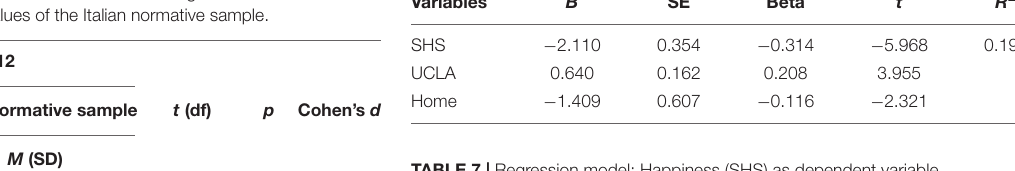
TABLE 7 | Regression model: Happiness (SHS) as dependent variable.